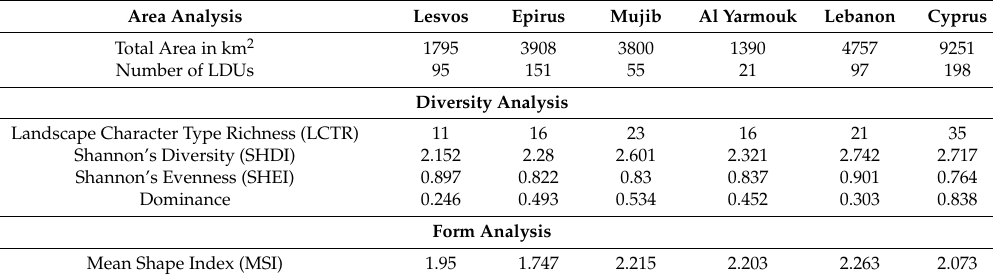
Table 4. Landscape Diversity in the six study areas.